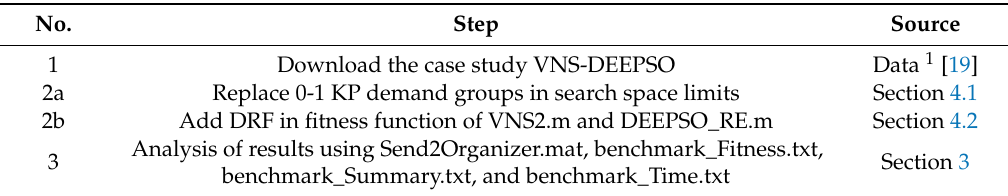
Table 4. Simulation general